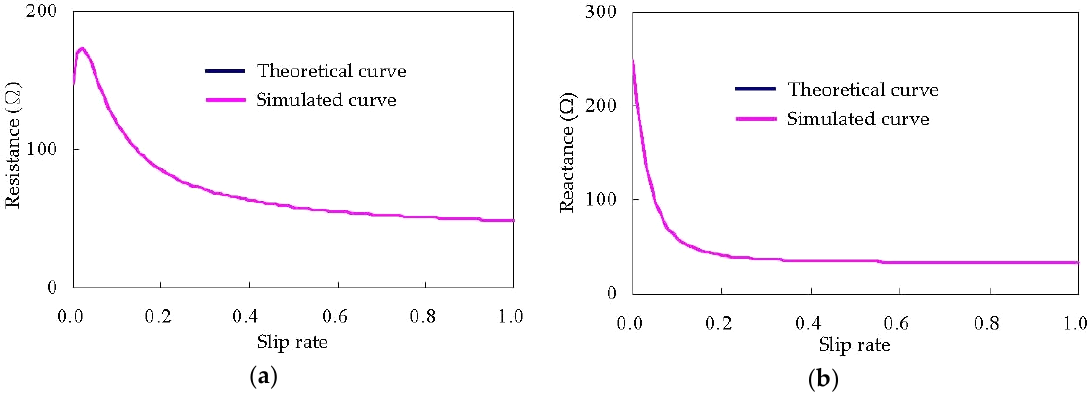
Figure 4. Polynomial fractional analysis results. ( a ) Input resistance comparison; ( b ) Input reactance comparison. Table 1. Comparison of the analysis results. Table 1. Comparison of the analysis